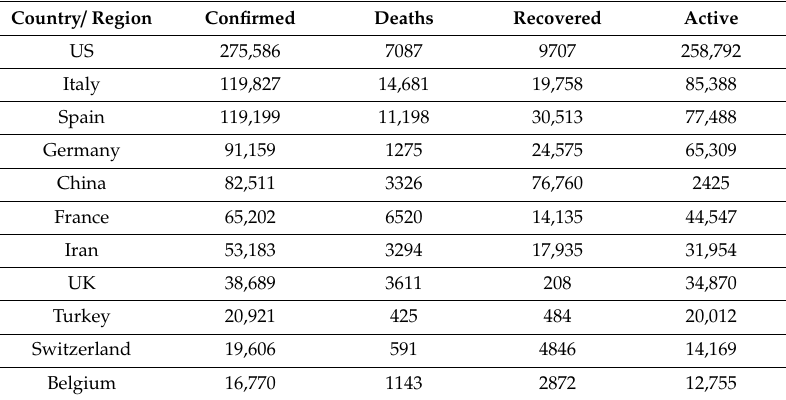
Table 1. Top 10 countries with active